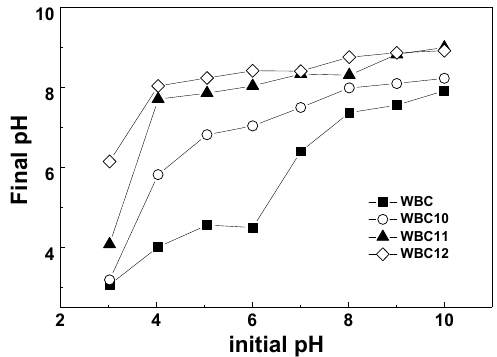
Figure 8. The effect of adsorption capacity in different pH (and pH change after adsorption). Figure 8. The e ff ect of adsorption capacity in di ff erent pH (and pH change after